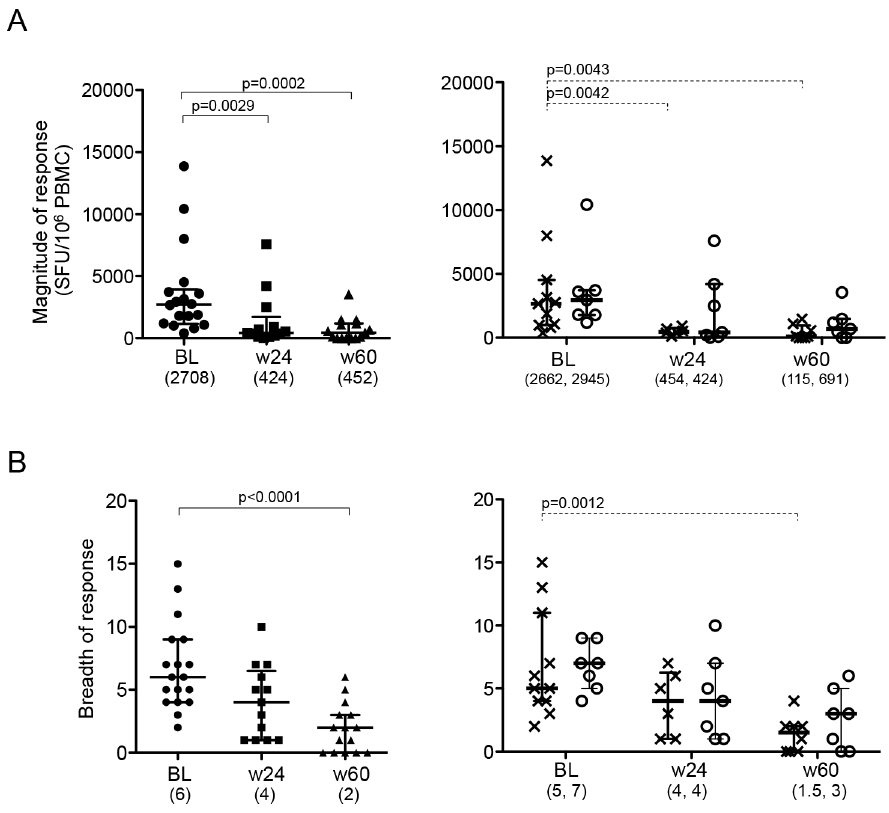
Figure 2. Longitudinal analyses of HIV-1-specific T cell responses in PBMC. The total magnitude (A) and breadth (B) of ELISpot responses at baseline (BL), week 24 (w24) and week 60 (w60) are shown for all subjects together (left panels) and for each study arm separately (right panels, crossed lines for control arm, circles for MVC arm). Horizontal lines represent median values of Spot-forming cells (SFC)/10 6 PBMC and the IQR, respectively. Mann-Whitney test was used in all statistical analysis. Only p values with significance after Bonferroni correction was shown. The numbers in parenthesis below the x-axis represent the median value.